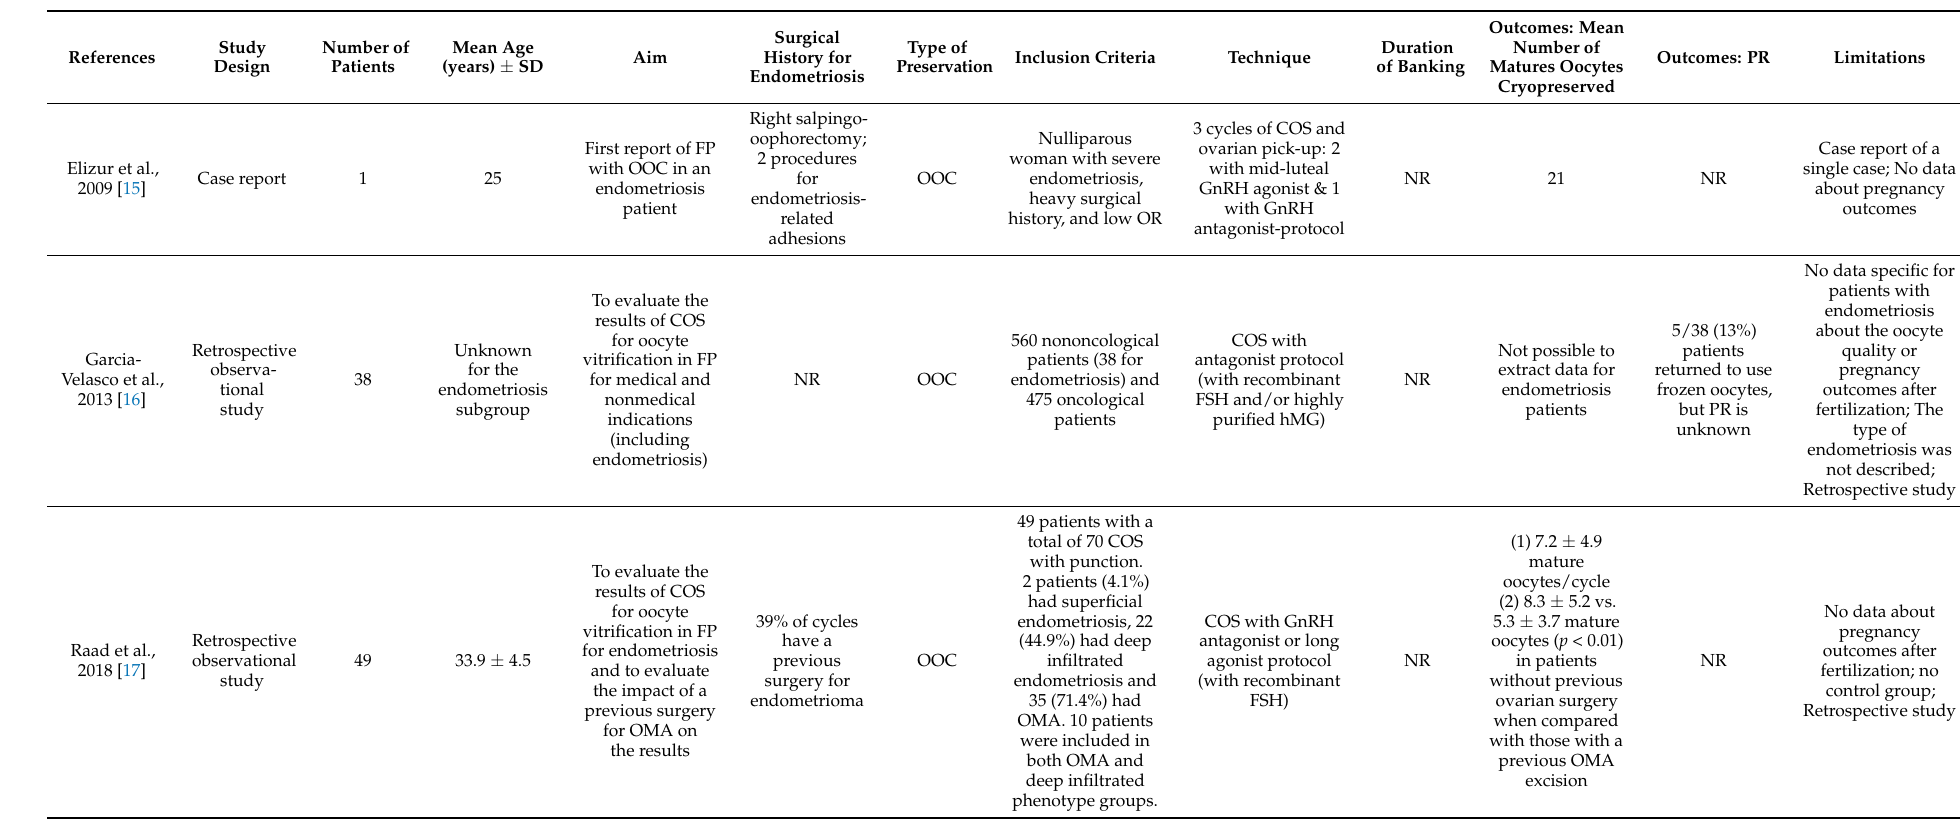
Table 1. Characteristics and outcomes of the studies